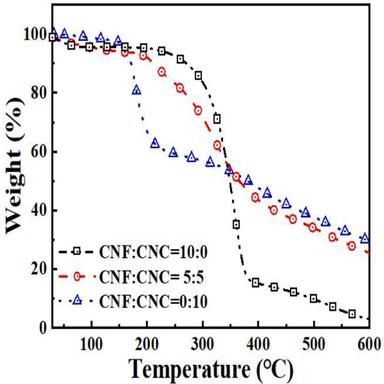
TGA of nanocomposite films with different ratios of CNF/CNC.